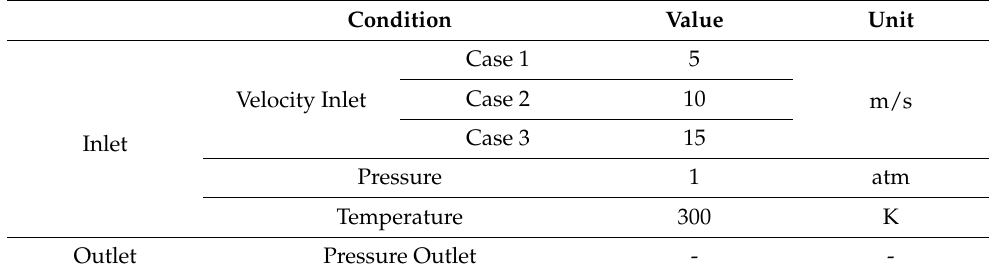
Table 2. Simulation boundary conditions.